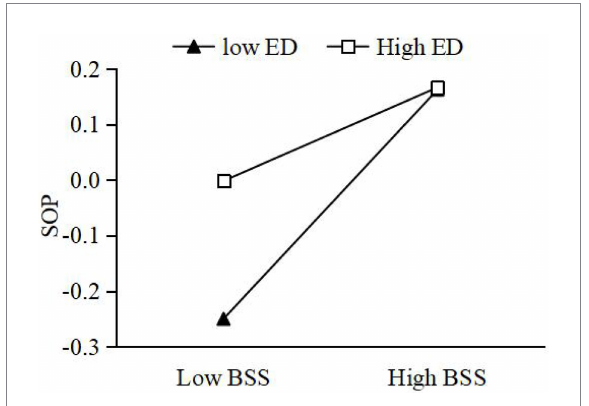
FIGURE 5 Moderating effect of environmental dynamism (ED) between boundary-spanning search (BSS) and social performance